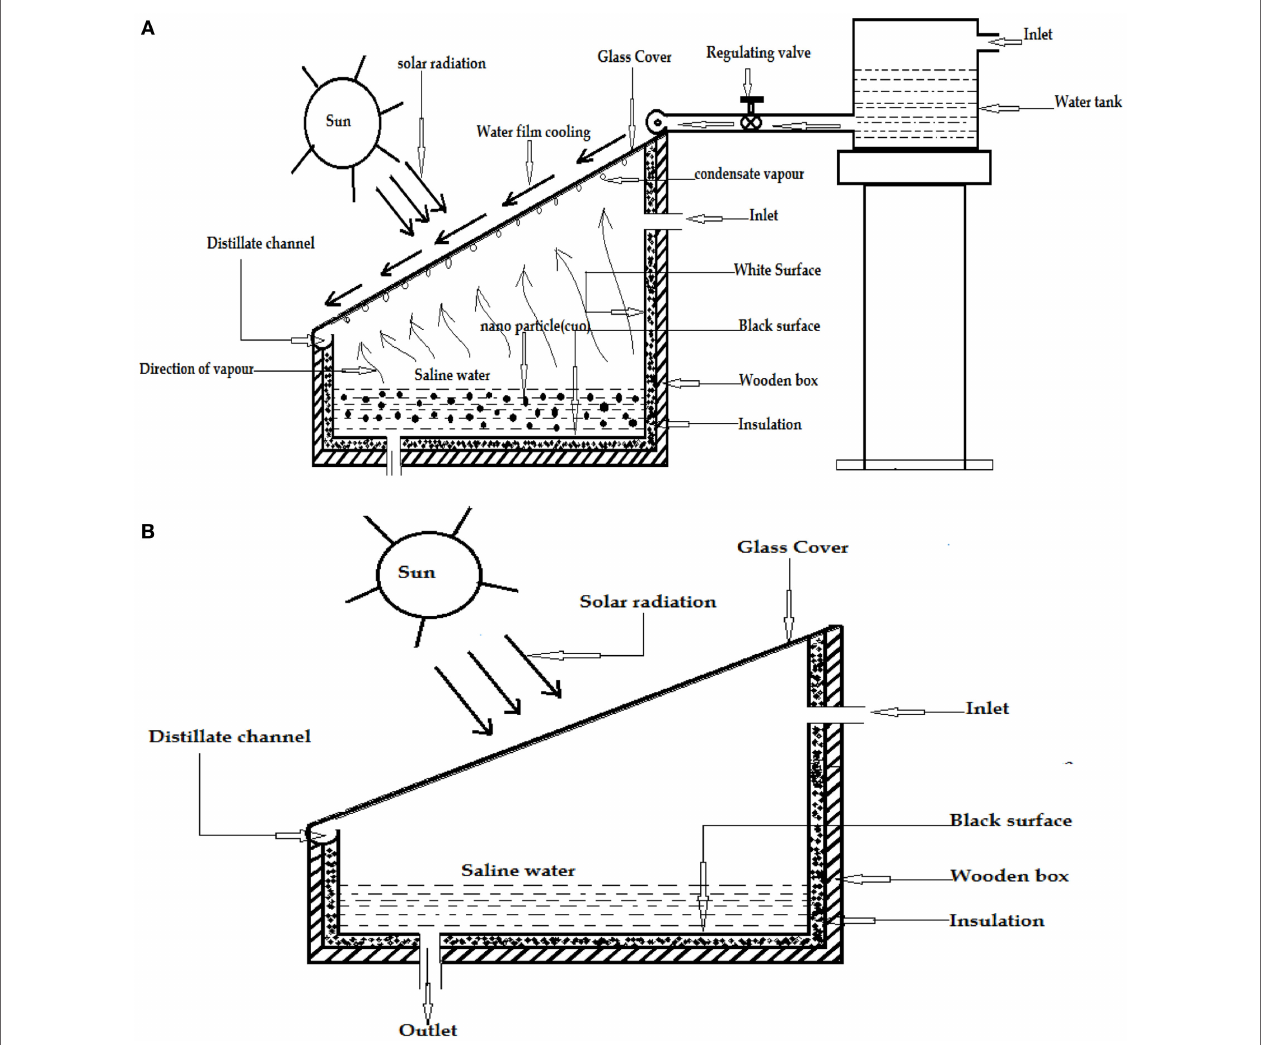
FIGURE 1 | Schematic view of modified solar still and conventional solar still. (A) Modified solar still. (B) Conventional solar still.